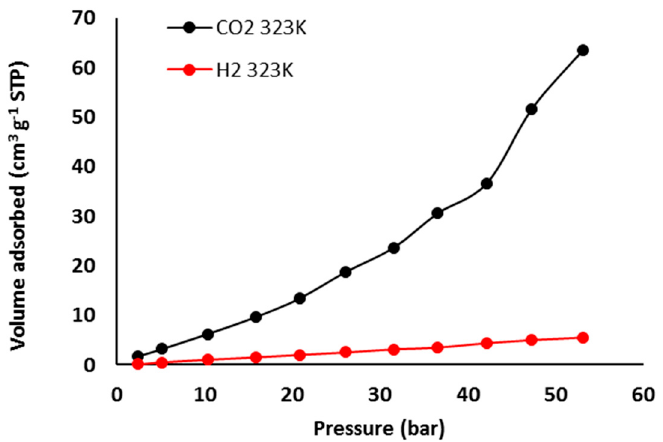
Figure 8. Adsorption isotherms of CO 2 and H 2 for polymer 6 .